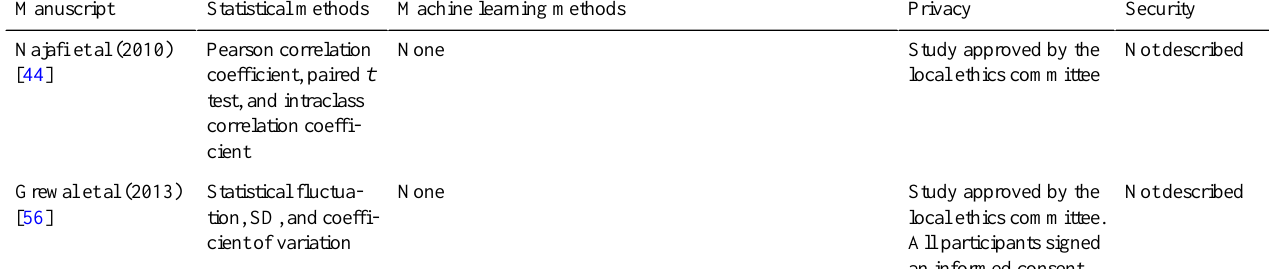
Table 3. Summary of processing techniques, privacy, and security ordered by the year of